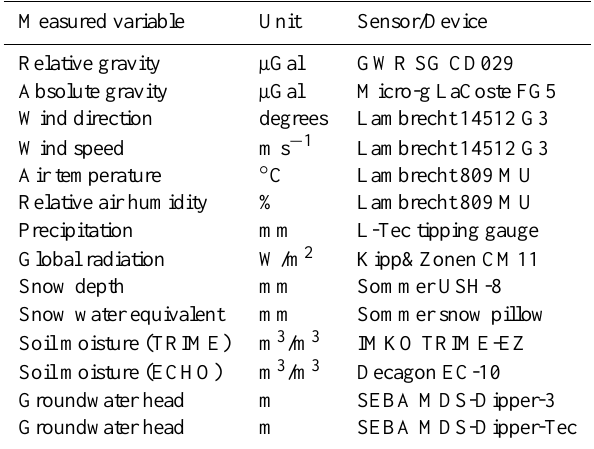
Table 1. Measured variable and the corresponding devices/sensors at the Geodetic Observatory Wettzell.